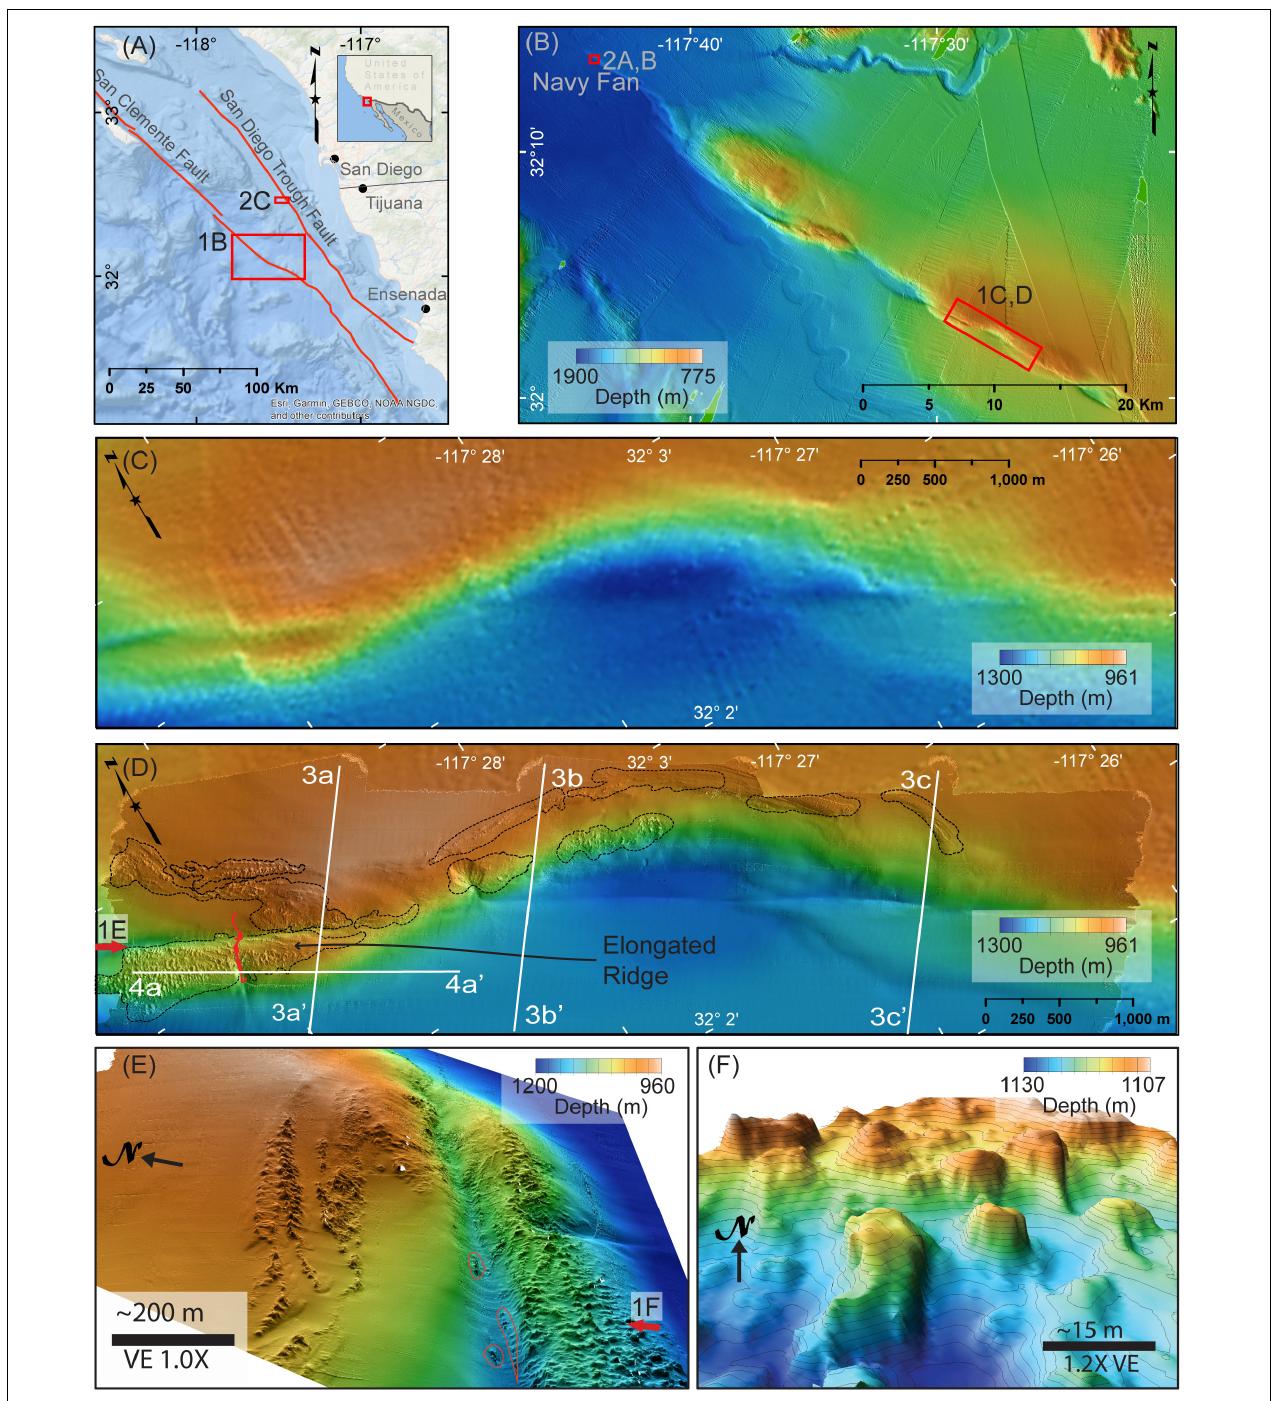
FIGURE 1 | (A) Regional map showing study area offshore California and Mexico’s border. (B) Surveyed sections of the San Clemente Fault. Red squares identify the locations of C,D , Figures 2A,B . (C) Bathymetry from surface-ship multibeam data of the main area surveyed along the San Clemente Fault. Resolution is 25 × 25 m. (D) Bathymetry from AUV data of the same area shown in C . Resolution is 1 × 1 × 0.25 m. The red line is the path of ROV dive DR767. White lines are the traces of chirp sub-bottom profiles shown in Figures 3 , 4 . Black dashed lines encircle areas with rough morphology indicative of barite mounds. Red arrow shows the direction of the perspective view shown in E . (E) A perspective view showing the rough morphology and central depression where the main strand of the San Clemente fault is presumably located. Abundant barite mounds are found on the elongated ridge south of the main strand of the fault and along strata on the top of the escarpment north of it. Red lines encircle linear arrangements of barite deposits found on the central trough that are parallel to the main strand of the fault. (F) A perspective view of barite mounds south of the trough, zoomed in, and vertically exaggerated to show individual mounds. Contours are 2 m.